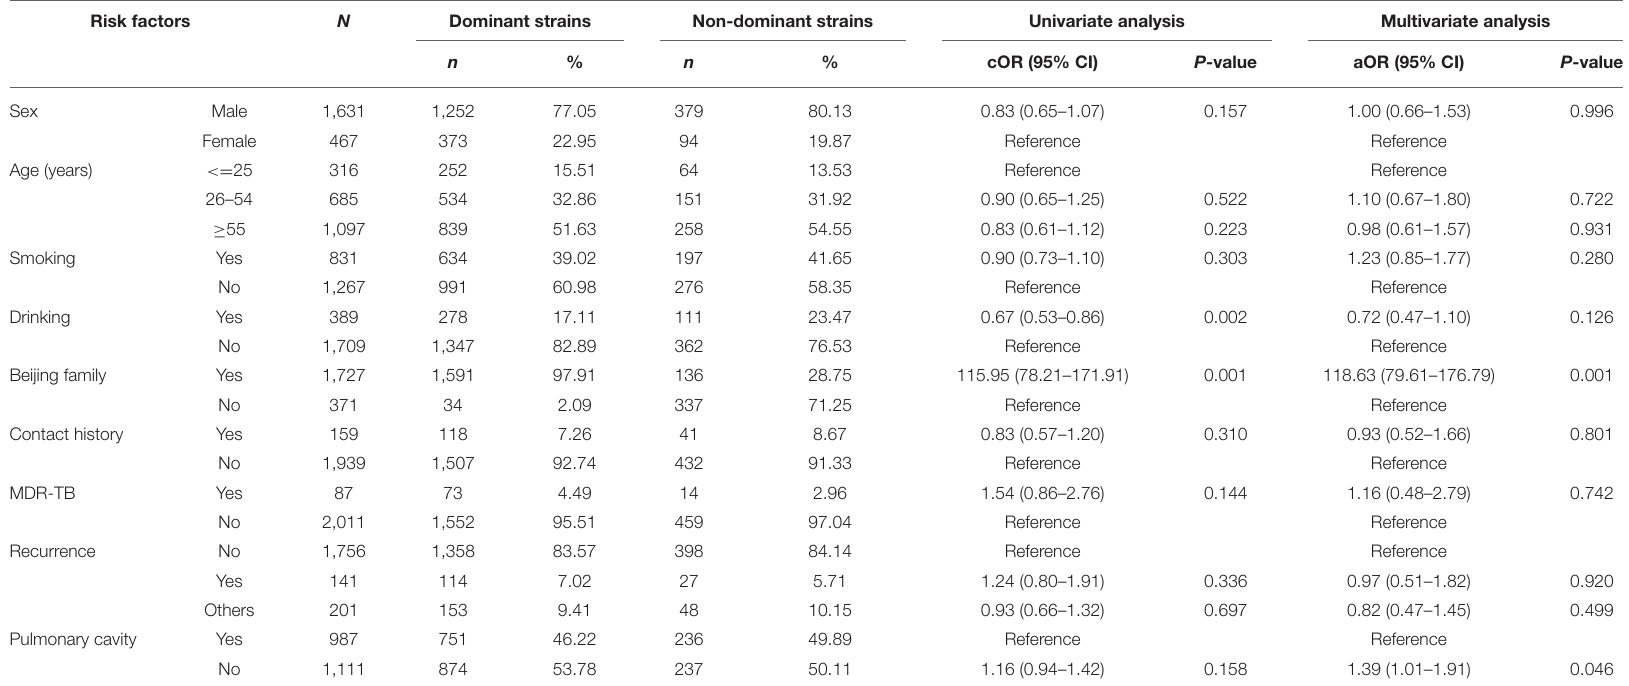
TABLE 1 | Factors associated with dominant and non-dominant strains distinguished by MIRU-VNTR Genotypes. Risk factors